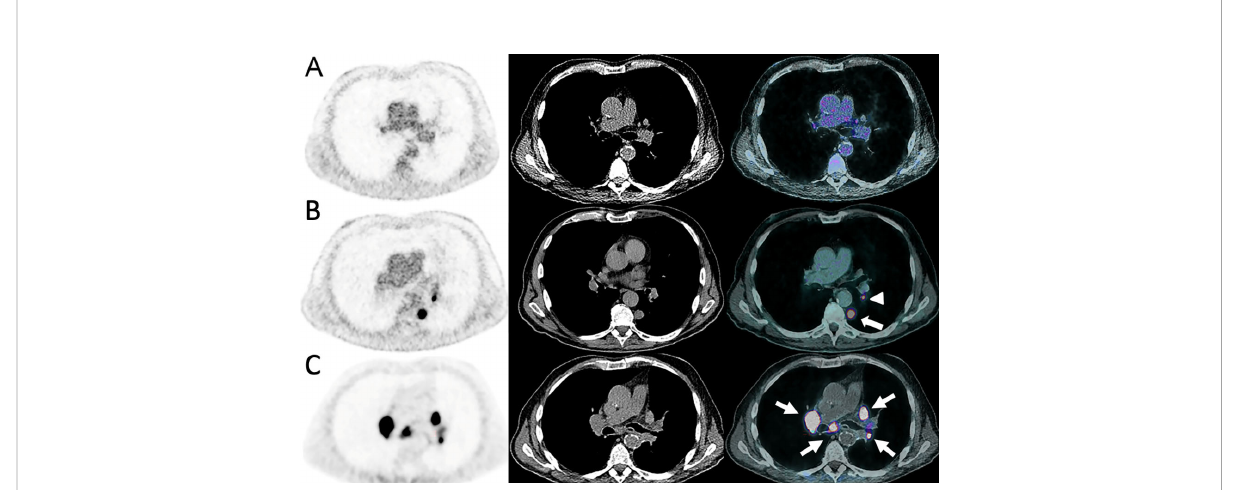
FIGURE 3 Sarcoidosis-like reaction in an 84-year-old male with cutaneous melanoma of unknown primary. The disease initially presented as the incidental discovery of a lung nodule on CT (A, B) . A 18 F-FDG-PET/CT was done and showed a solitary left pulmonary lower lobe nodule (arrow) with a homolateral hilar lymph node (arrowhead) which were both highly metabolic. Mediastinum and upper hilum were disease free. The patient underwent upfront surgery which established the diagnosis. Nivolumab was administered 1 month post-surgery and after 4 cycles the patient developed dyspnea. (C) A 68 Ga-DOTATOC-PET/CT showed intense and diffuse uptake in enlarged mediastino-hilar lymph nodes (arrows) suggesting a reactive in fl ammatory process with high uptake of activated lymphocytes strongly expressing STTR-2 targeted by 68